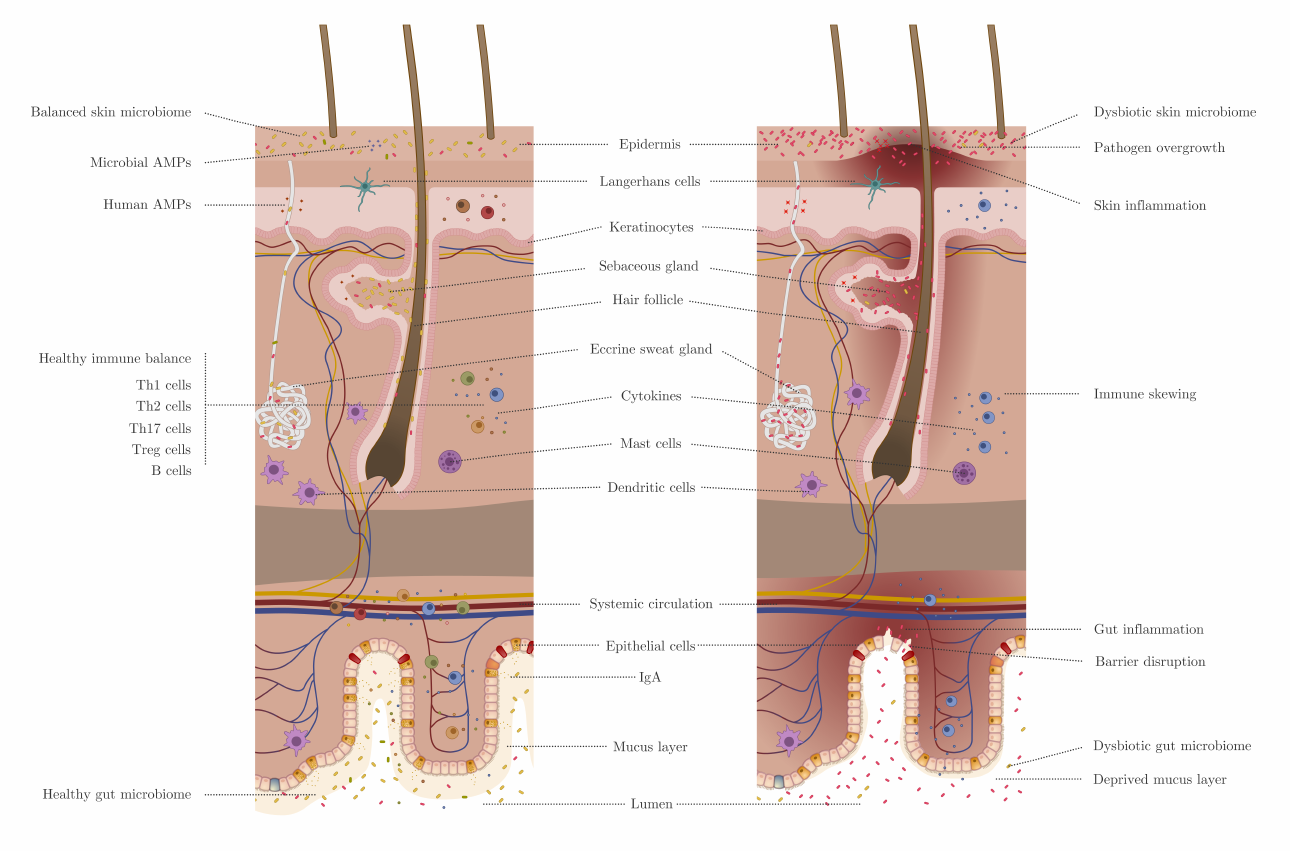
Figure 1. Inflammatory and microbial influences between the gut and skin for a healthy state ( left ) and a dysbiotic state ( right ): The intestinal and epidermal barriers are connected through the systemic circulation (blood and lymph) and are visualized here together in a simplistic manner. The dysbiotic state is characterized by an impaired gut barrier (imbalance in gut microbiome, reduced mucus layer, reduced IgA secretion, barrier disruption, intestinal permeation into the bloodstream, and gut inflammation) and an impaired skin barrier (imbalance in skin microbiome, reduced human and microbial antimicrobial peptides (AMP) production, skin rashes/thickening/lesions, and skin inflammation). Gut and skin dysbiosis are connected through an immune imbalance (Th2 skewing in this example), whereas crosstalk can be